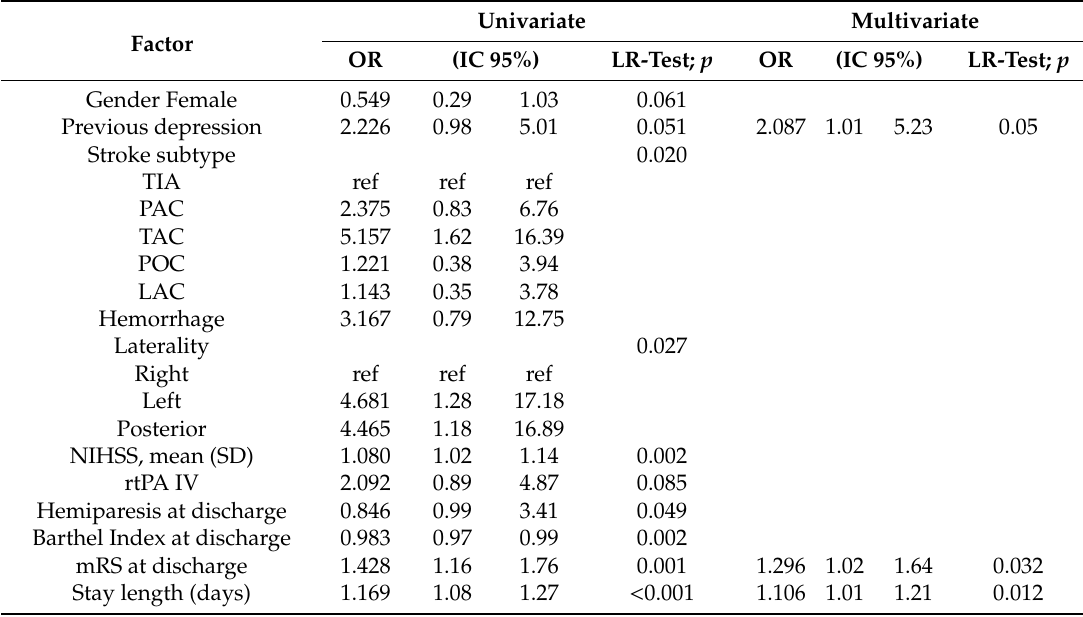
Table 2. Logistic regression analysis for